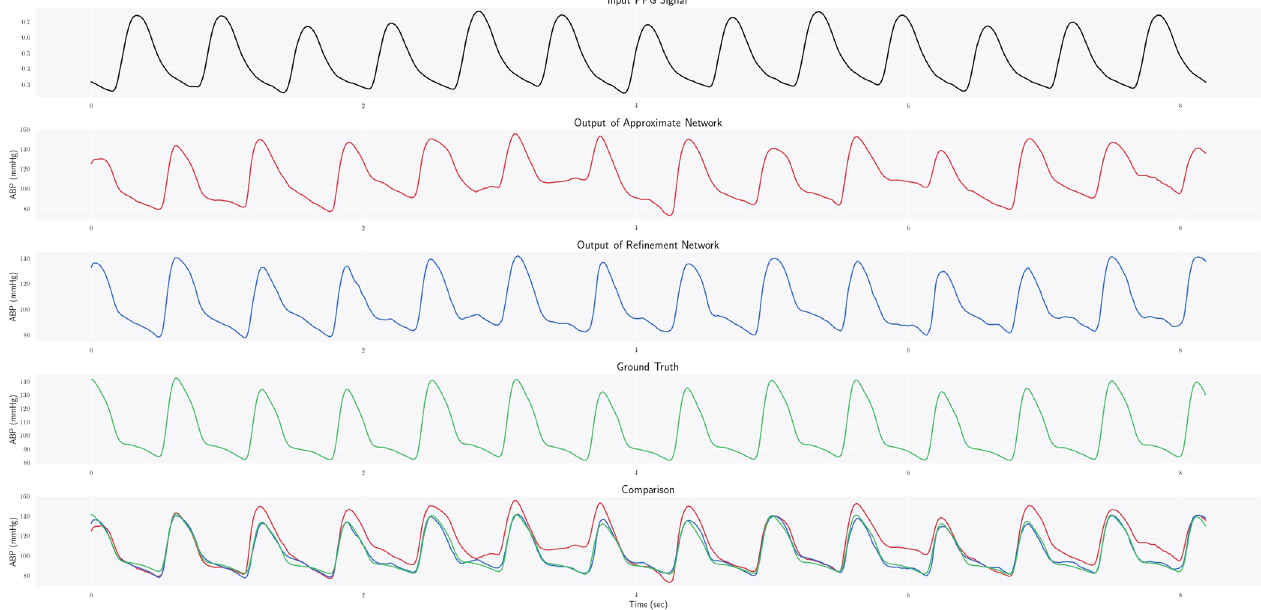
Figure 4. Demonstration of output from the PPG2ABP pipeline .